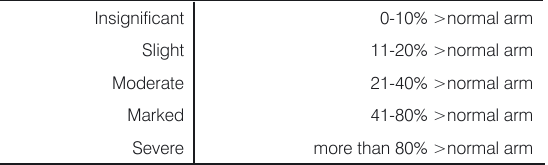
Table 1. Stillwell classification for